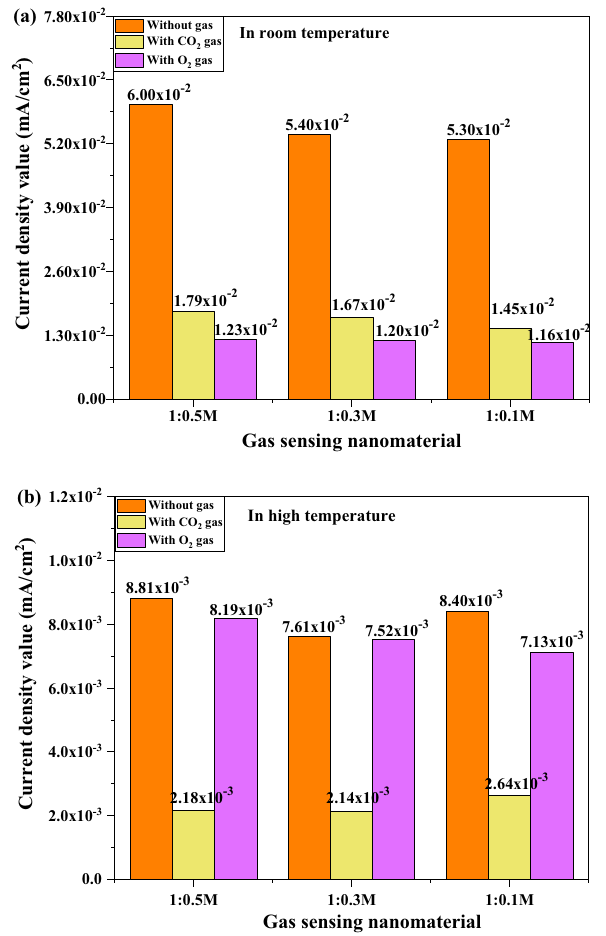
Figure 12. Current density value of the gas sensor with gas and without gas under ( a ) room temperature (25 °C) and ( b ) high temperature conditions (350